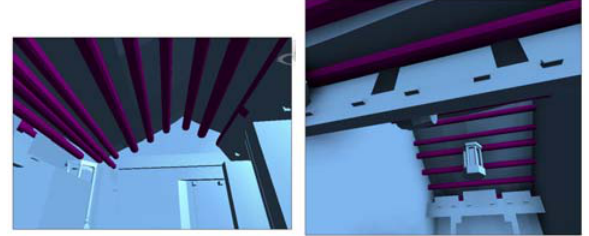
Figure 8. Autodesk Revit on Roof of Xia-Hai City God